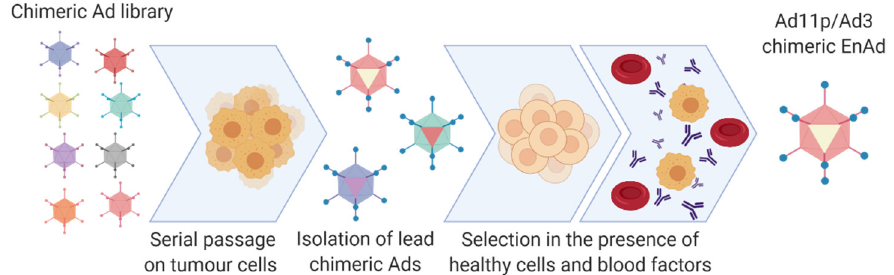
Figure 5. Method of production for oncolytic virus, EnAd (PsiOxus Therapeutics Ltd., Abingdon, UK). Serial passages of an Adenoviral library in tumour cells lead to chimeric Ads development. Selection with healthy cells and blood factors removes those that bind off-target receptors, lead to Ad11p/Ad3 chimeric EnAd being selected for. Created with BioRender.com.